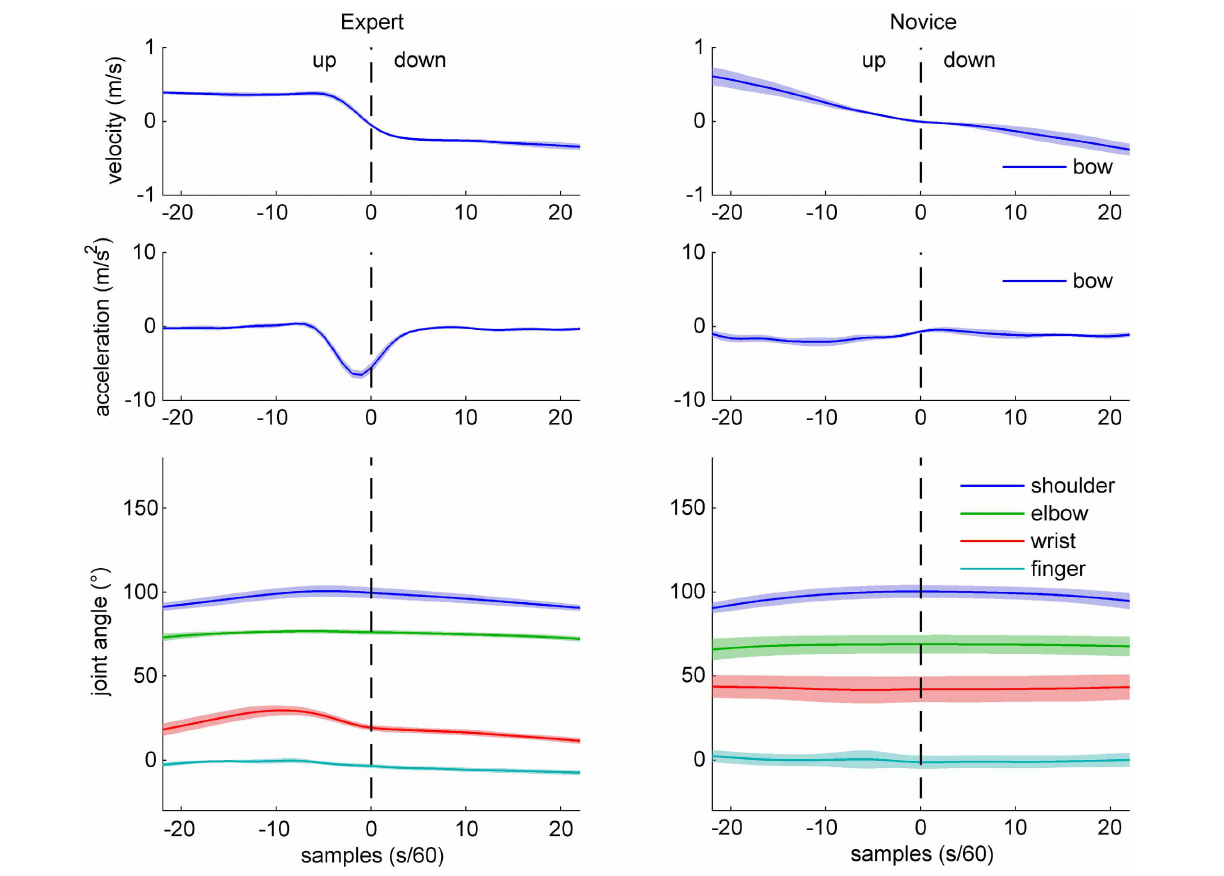
FIGURE 2 | Sample data of bow kinematics (velocity and acceleration) and joint angle movement for an expert (left) and a novice (right) cello player, during an up-down bow reversal. Shaded areas indicate SD across